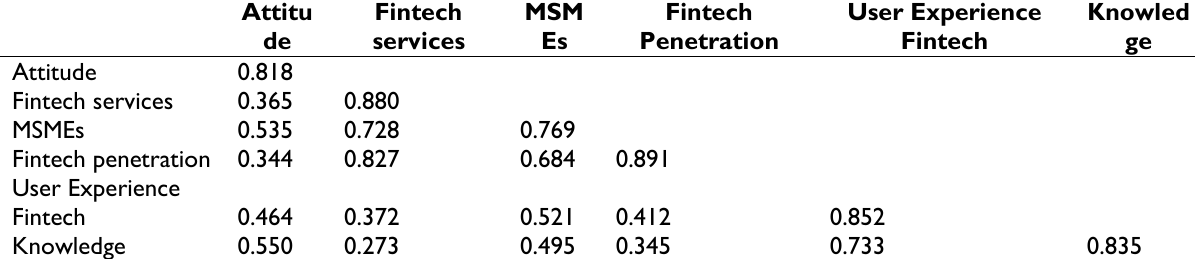
Table 4. Fornell-Lacker